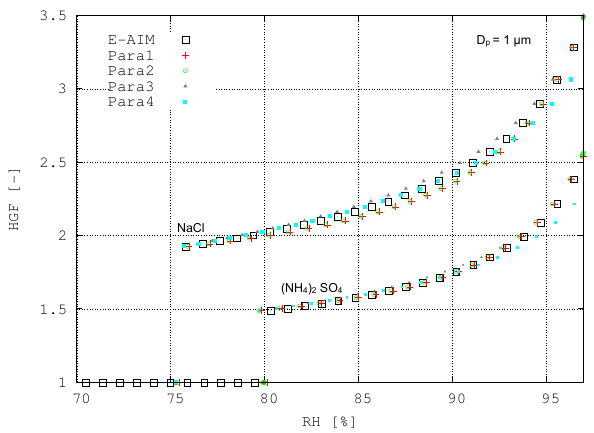
Fig. 2. Same data as Fig. 1 but for RH values within the subsaturated regime, i.e. 97 ≤ RH ≤ 100 [%] . Fig. 1. Hygroscopic mass equivalent (diameter) growth factor (HGF) for pure NaCl (cr) and (NH 4 ) 2 SO 4(cr) particles with a dry diameter D s = 1 [ µ m] for RH ≤ 97 [%] , showing the four differ- ent water activity, a w -parameterizations, summarized in Table 1 in comparison to the results of E-AIM.